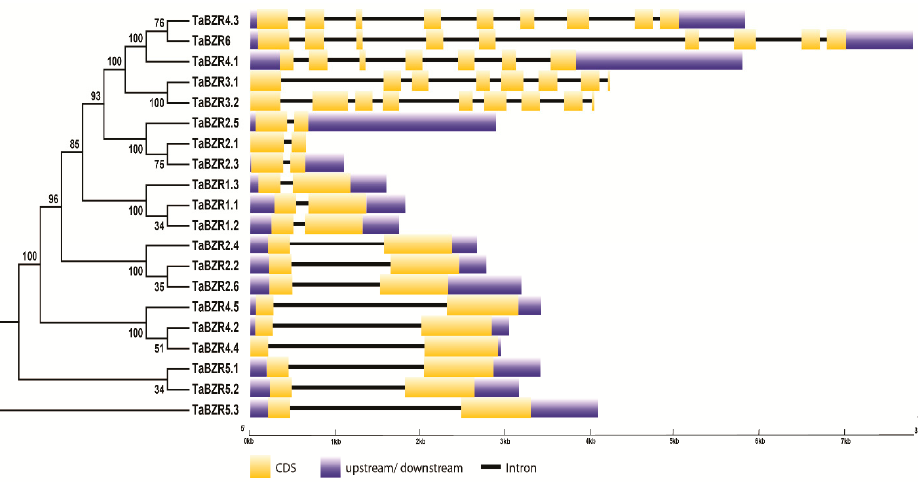
Figure 4. Exon-intron organization of the TaBZR genes. Yellow boxes represent exons, untranslated regions (UTRs) are indicated by blue boxes, and black lines represent introns. The lengths of the boxes and lines are scaled based on gene length. The exon and intron sizes can be estimated using the scale at the bottom.